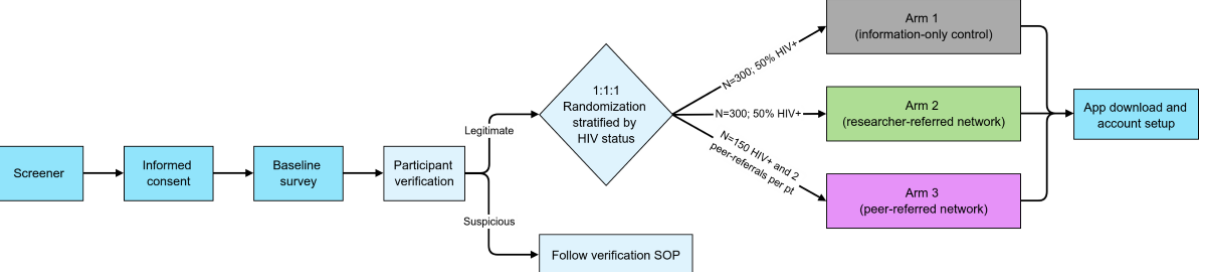
Figure 1. HealthMpowerment intervention enrollment and randomization procedural flow diagram. SOP: standard operating